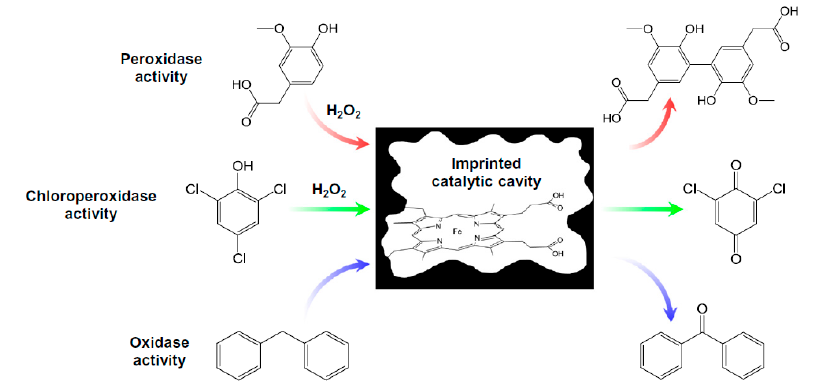
Figure 7. Hemin-based catalytically active MIPs. Reprinted by permission from [9].